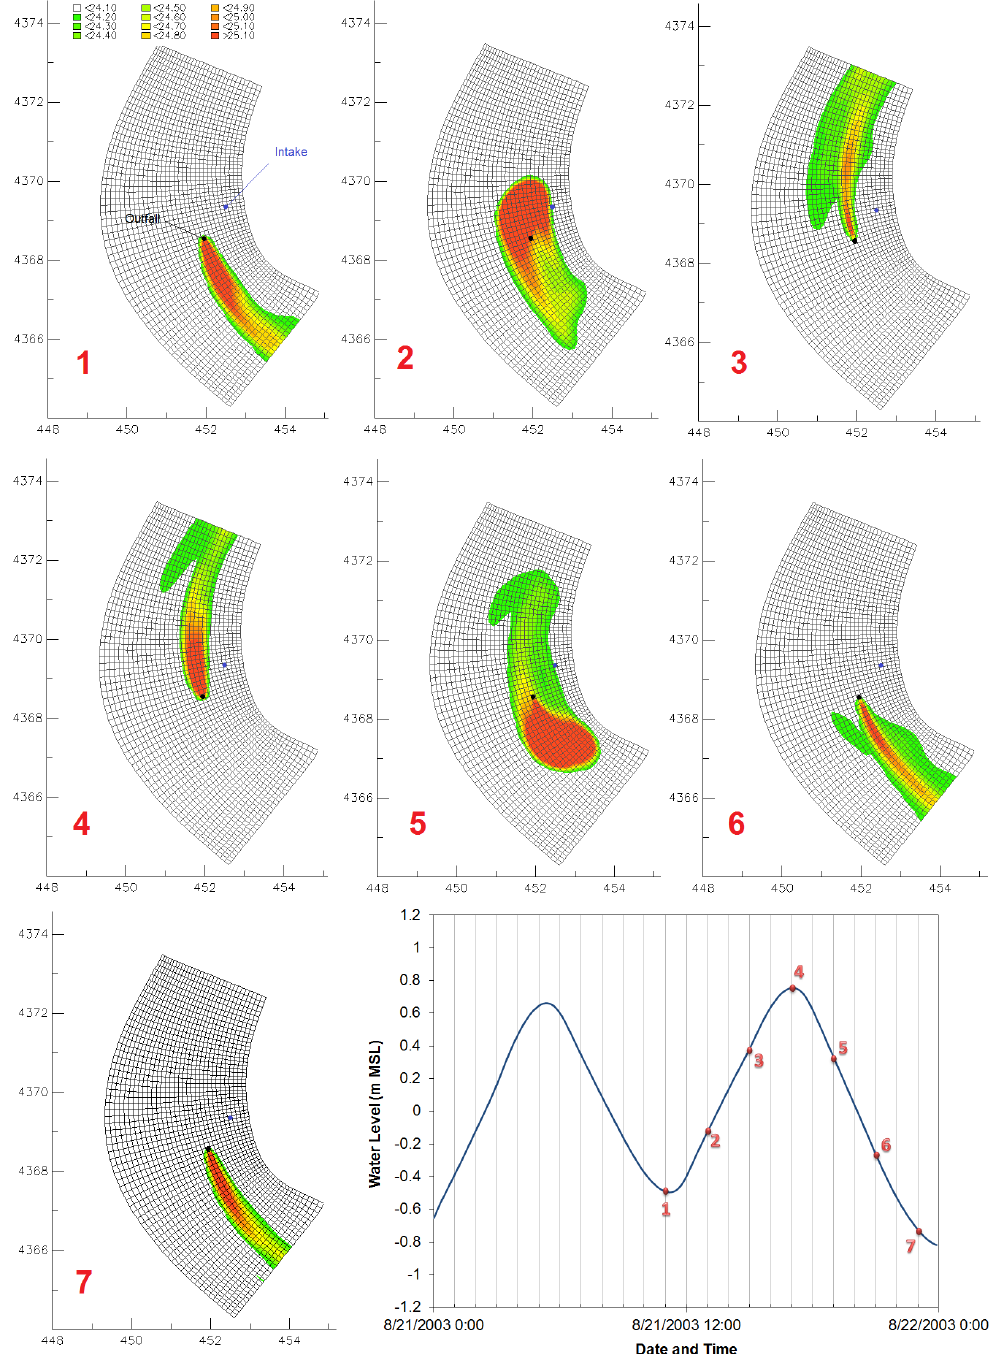
Figure 10. Thermal plume pattern during tide at the surface: Scenario